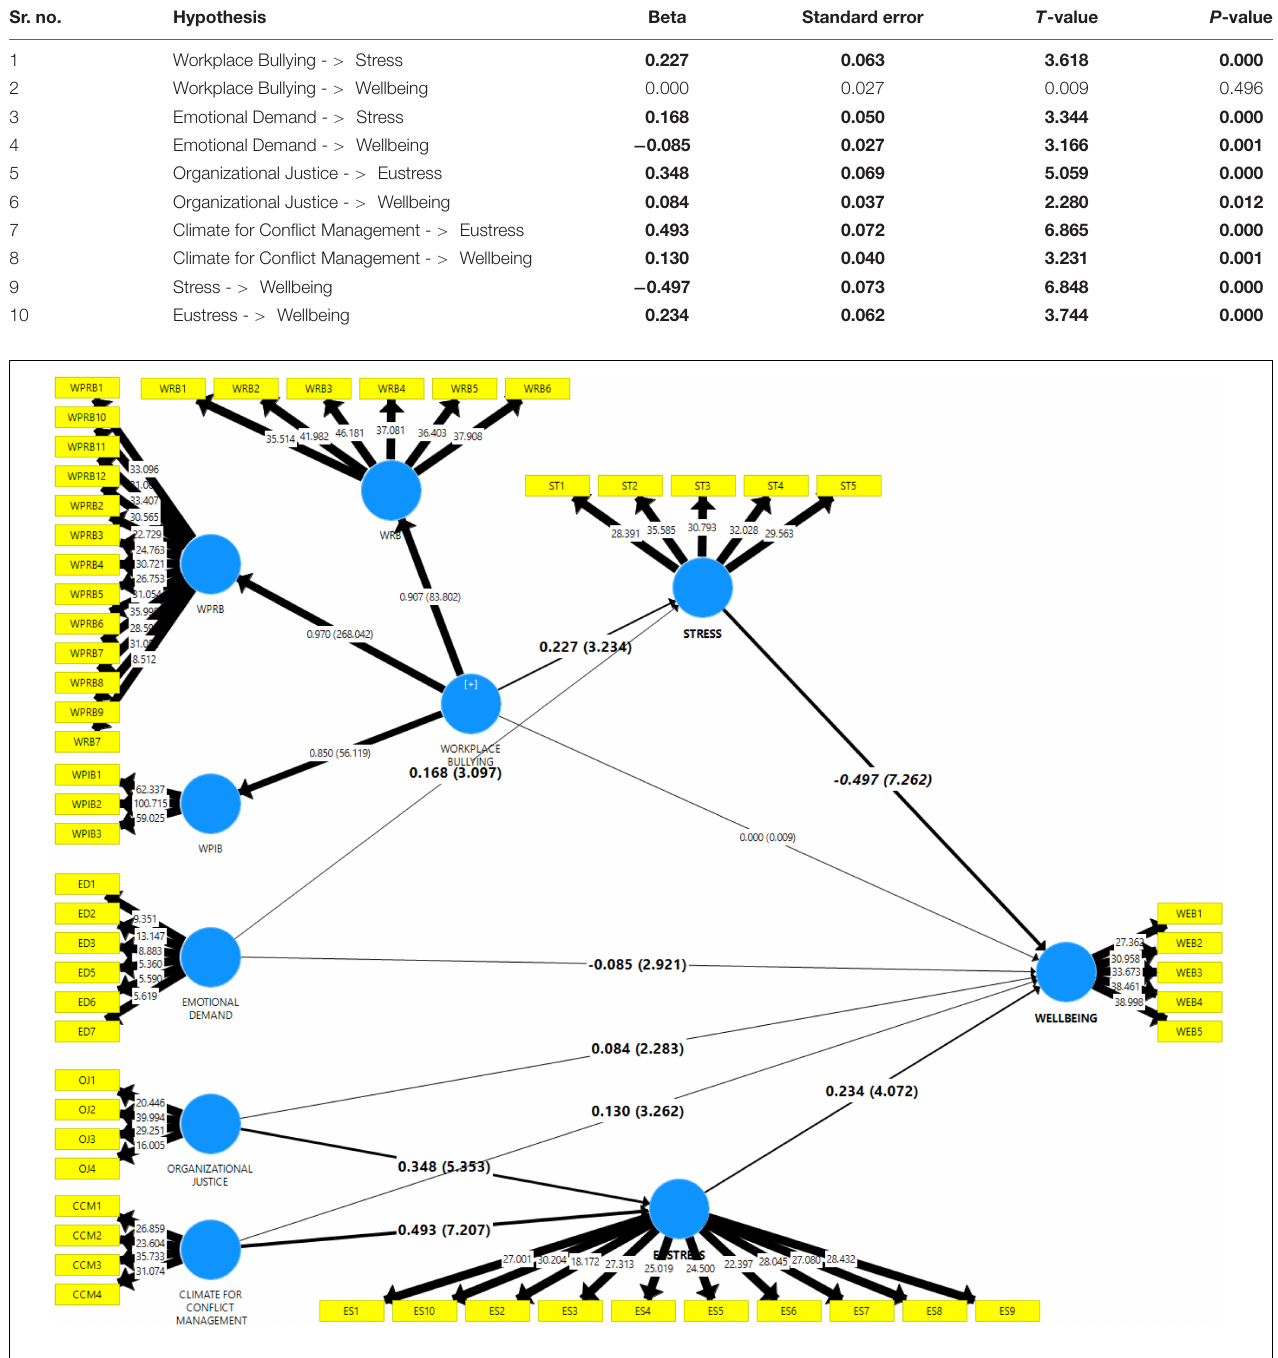
FIGURE 1 | Structural